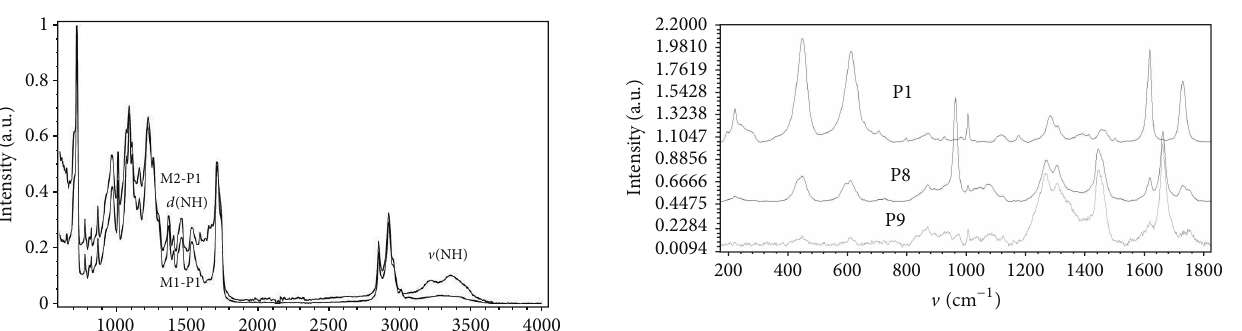
Figure 9: Micro-Raman spectra from areas of salmon adhesion in sample M1; points 01, 08, and 09 in Figure 5.